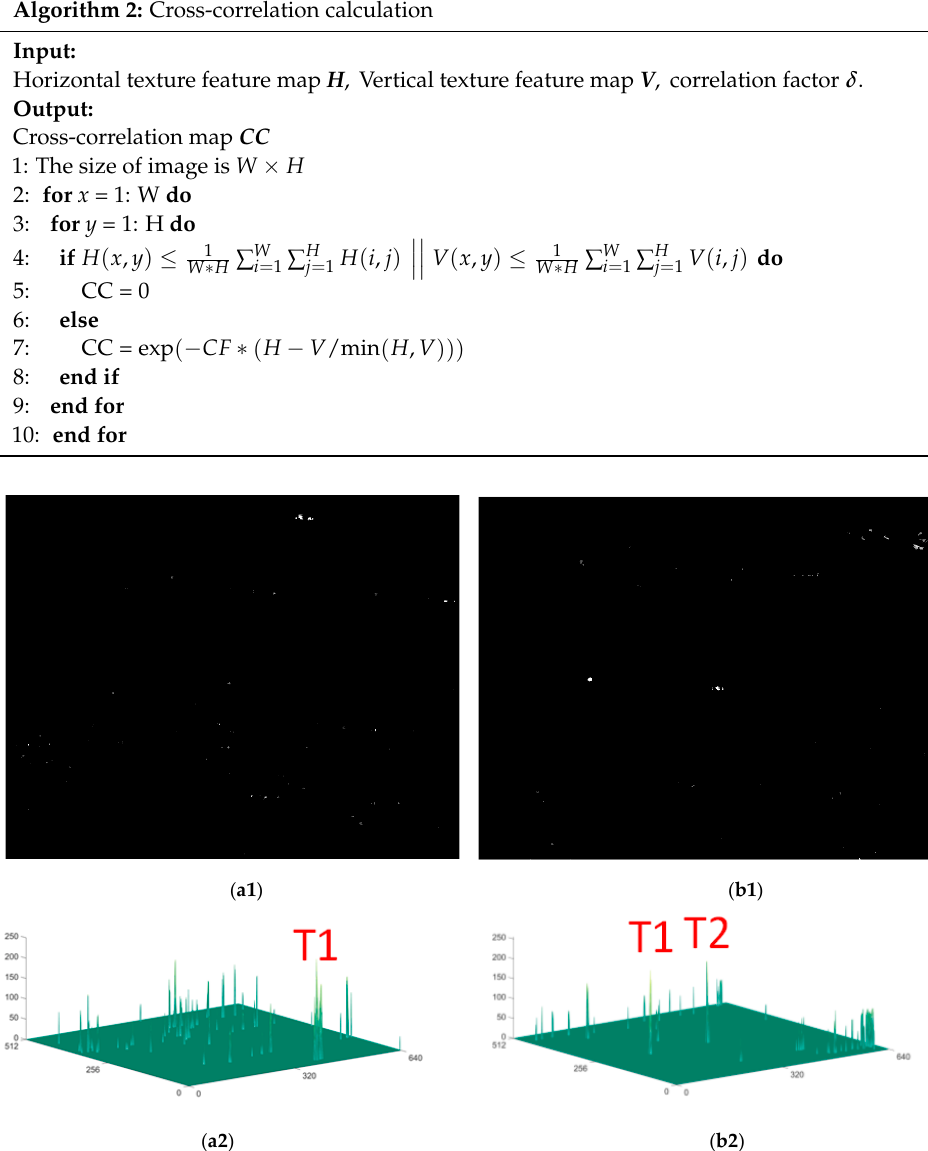
Figure 8. CC calculation results of Horizontal and vertical IsD multi-scale feature fusion image (Algorithm 2). ( a1 ) CC result of image A. ( a2 ) Three dim representation of CC result of image A. ( b1 ) CC result of image B. ( b2 ) Three dim representation of CC result of image B. Algorithm 2: Cross-correlation calculation